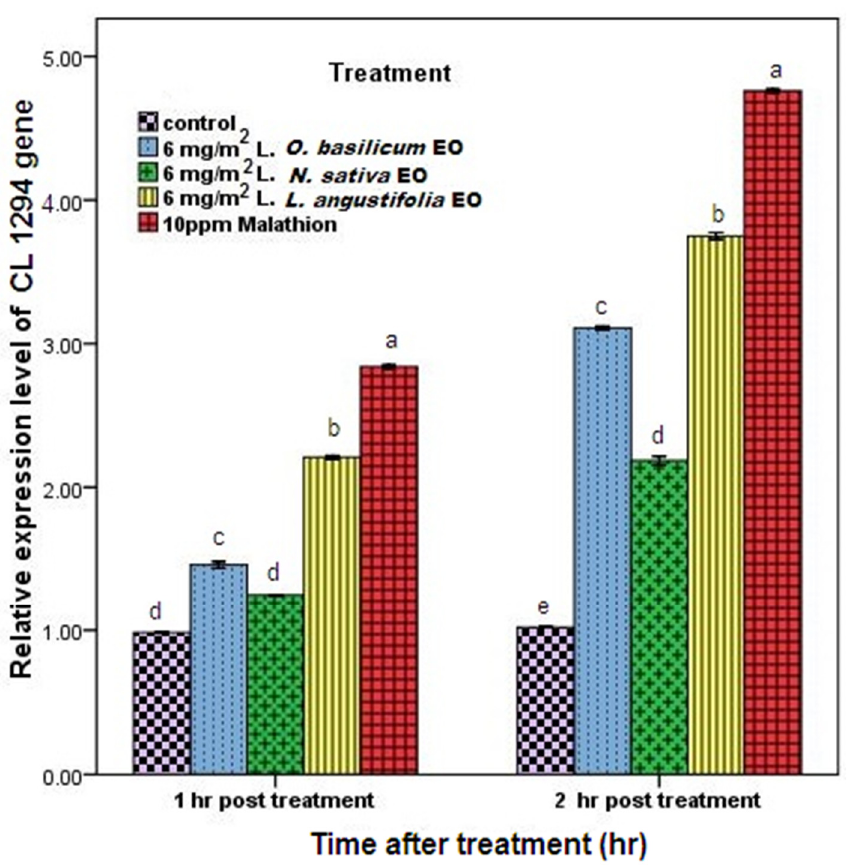
Figure 9. Relative gene expression of CL 1294 gene in S. oryzae adults after 1 and 2 h treated with 6 mg/cm 2 of O. basilicum, N. sativa, and L. angustifolia EOs (mean ± SD) compared with standard chemical insecticide (10 ppm malathion). Different letters indicate significant differences between different treatments at p <